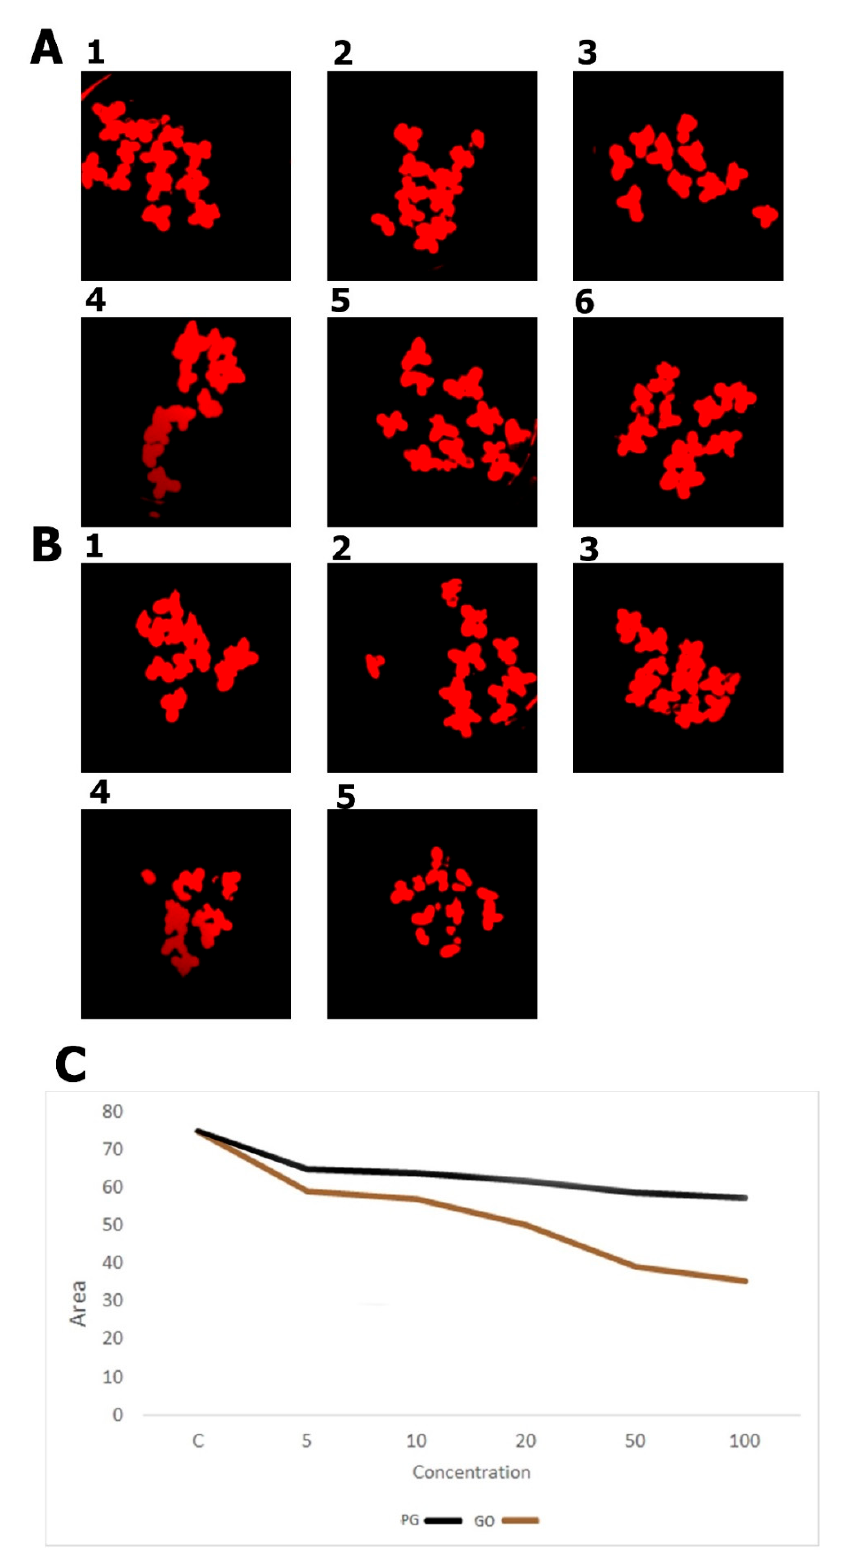
Figure 8. The area of fronds determined from the images after autofluorescence analysis. ( A1 ) Control group; ( A2 ) PG 5 µg/mL; ( A3 ) PG 10 µg/mL; ( A4 ) PG 20 µg/mL; ( A5 ) PG 50 µg/mL; ( A6 ) PG 100 µg/mL; ( B1 ) GO 5 µg/mL; ( B2 ) GO 10 µg/mL; ( B3 ) GO 20 µg/mL; ( B4 ) GO 50 µg/mL; ( B5 ) GO 100 µg/mL; ( C ) calculated area of the fronds.